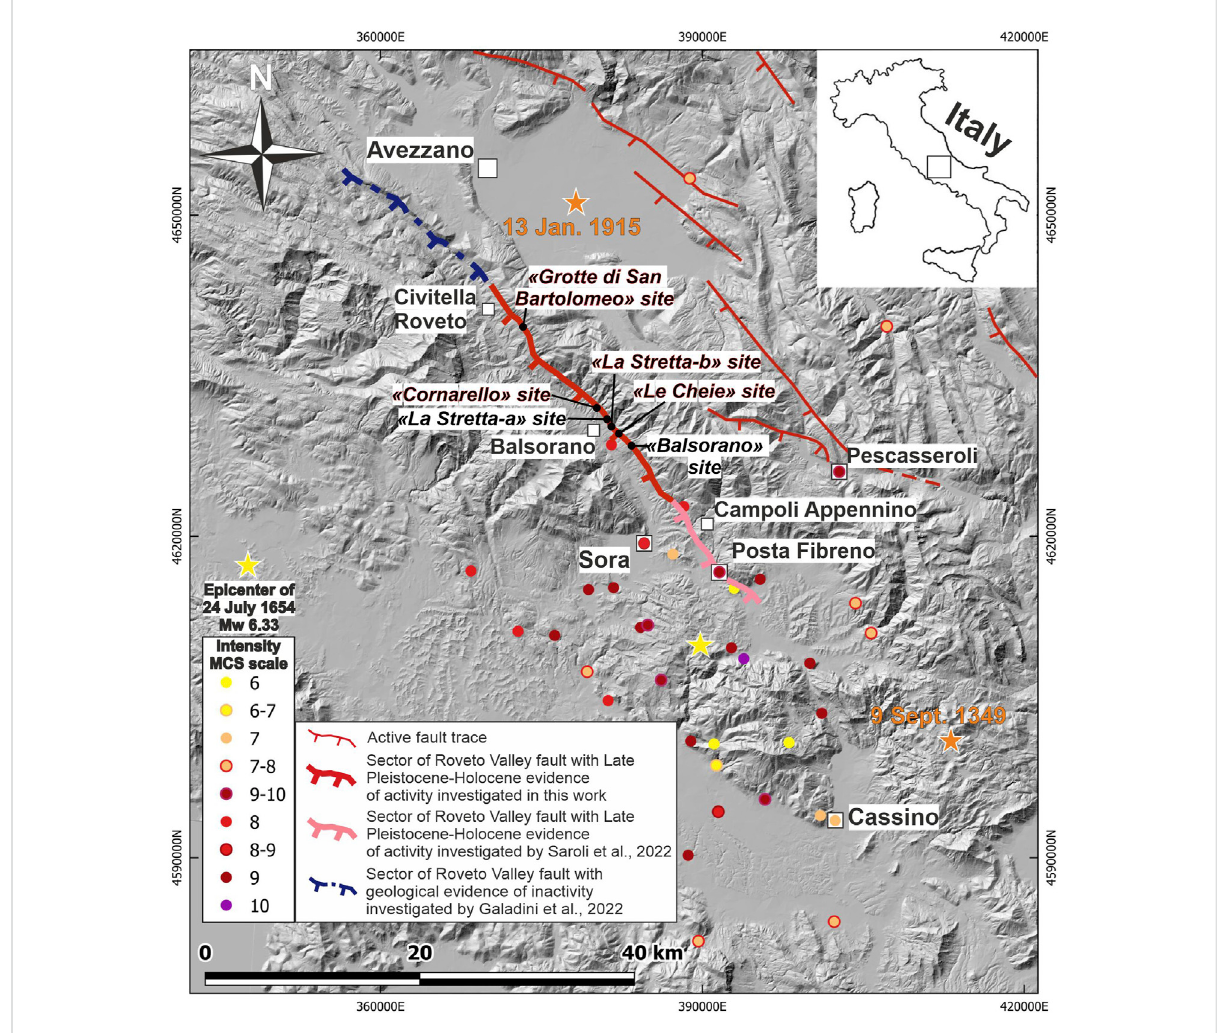
FIGURE 15 Digital terrain model (shaded relief) of the Roveto Valley Fault (red line) area on which the intensity distribution (MCS scale) of the 1654 earthquake (Mw 6.33) is reported (from Rovida et al.,